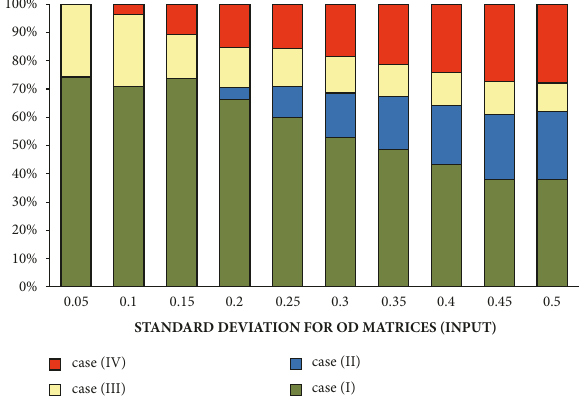
Figure 8: The predicted uncertainty for the link No. 6, applying normal distribution scenarios [27].